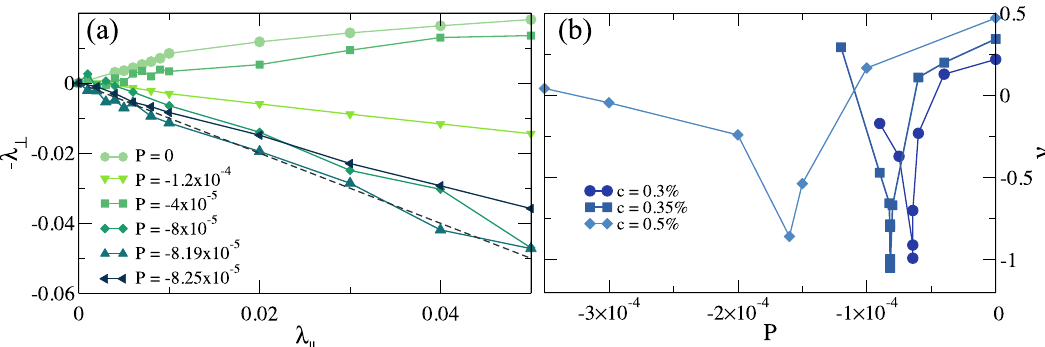
Fig. 2 Hyper-auxeticity. ( a ) Negative transverse strain ( λ ⊥ ) as a function of longitudinal strain ( λ ∥ ) for the Diam-0.35% system for different values of pressure. The dashed straight line has negative unitary coef fi cient well-approximating the data for P = P min = − 8.19 × 10 − 5 k B T / σ 3 (hyper-auxetic point); ( b ) Poisson ’ s ratio ν as a function of negative P for diamond hydrogels with c = 0.30%, 0.35%, 0.5%. Source data are provided as a Source Data fi le.